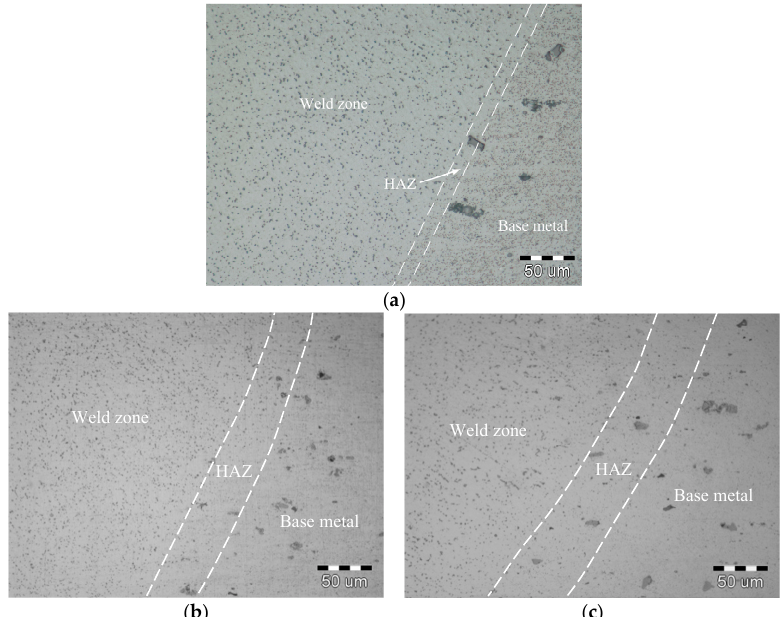
Figure 10. Microstructure of the welded joint: ( a ) laser welding; ( b ) 3.5 kA electric current-aided laser welding; ( c ) 5.0 kA electric current-aided laser welding.